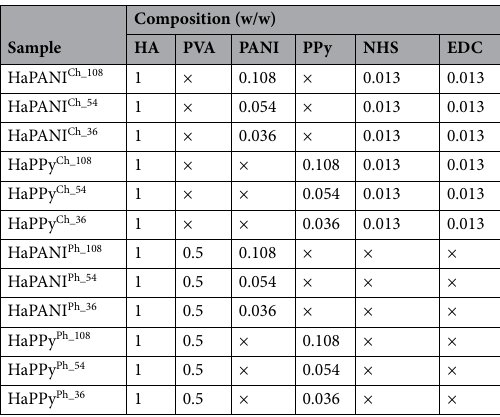
Table 1. Composition of scaffolds. The samples are labelled according to the type of CP-based colloidal particles (PANI, PPy); the method of crosslinking, i.e. chemical (Ch) or physical (Ph); and the concentration of CP-based colloidal